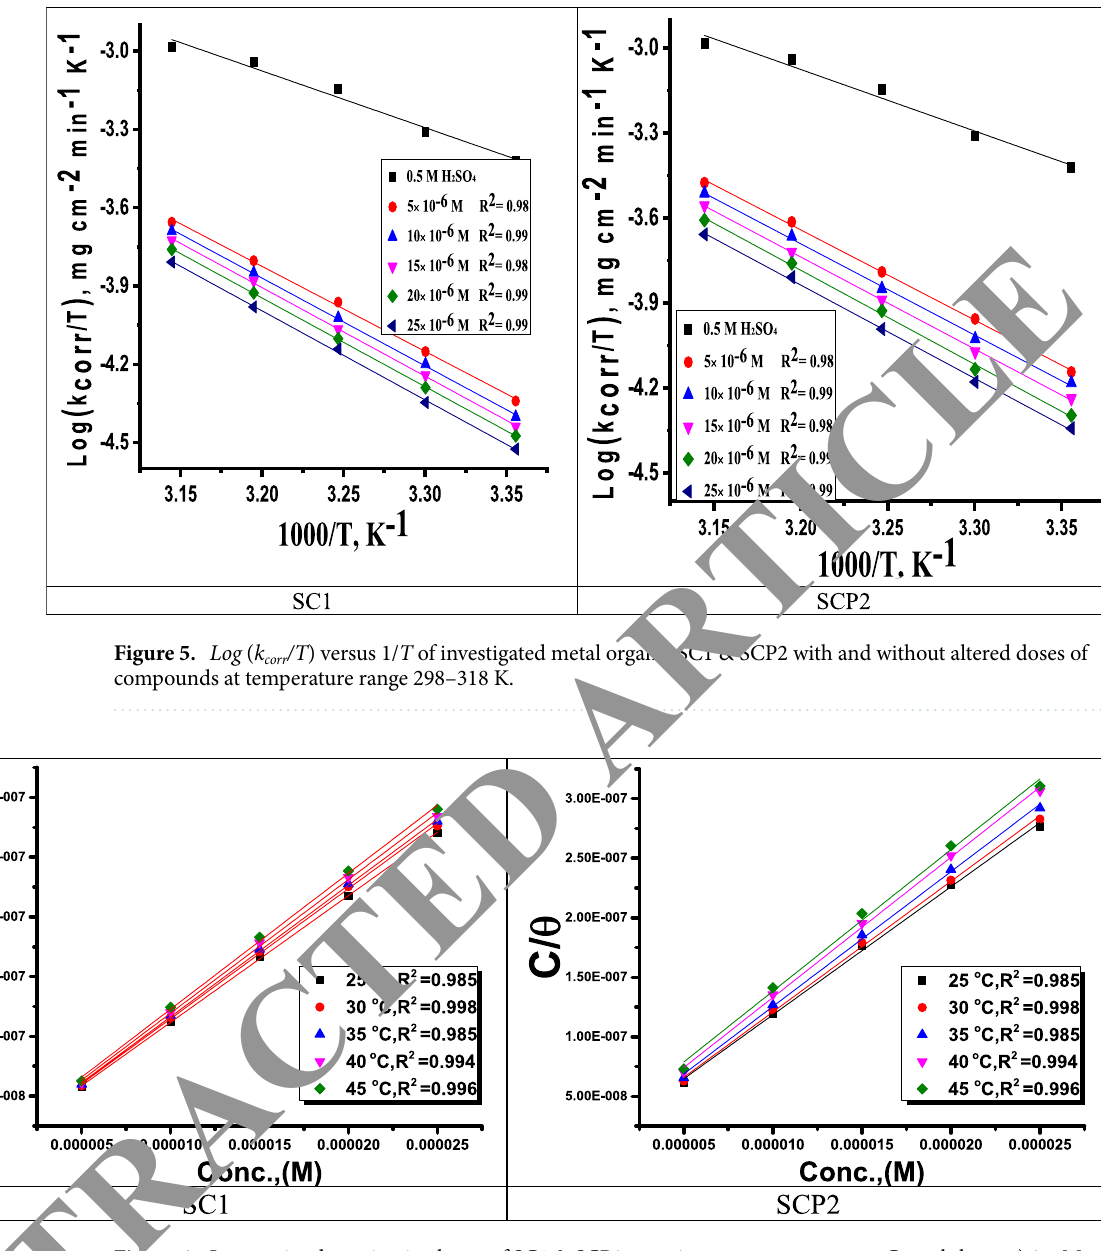
Figure 6. Langmuir adsorption isotherm of SC1 & SCP2 at various temperatures on a C-steel sheet at) 0.5 M H 2 SO 4